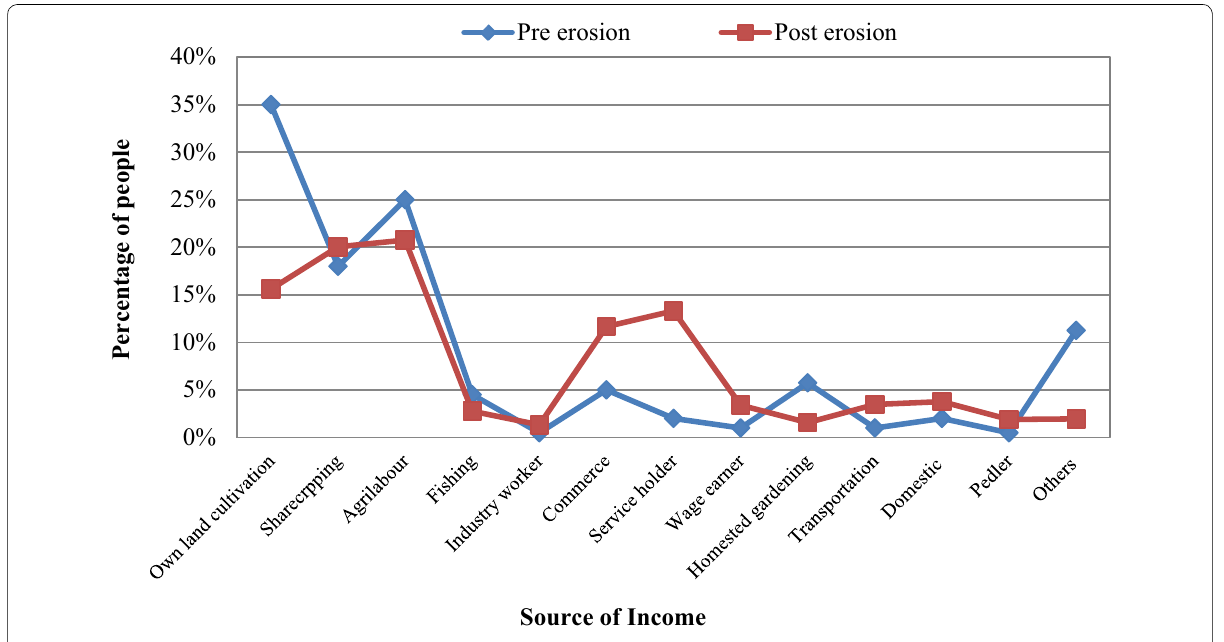
Fig. 4 Source of income in study area at pre‑and‑post erosion